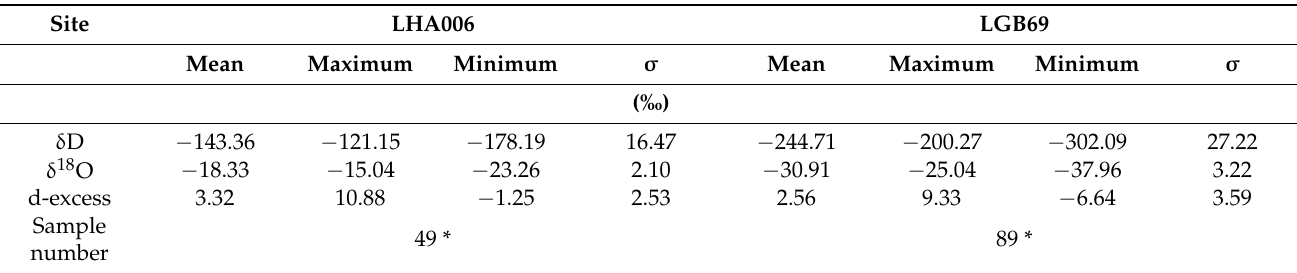
Table 9. Mean, maximum, minimum, and standard deviation ( σ ) of δ D, δ 18 O, and d-excess values in the LHA006 and LGB69 snow